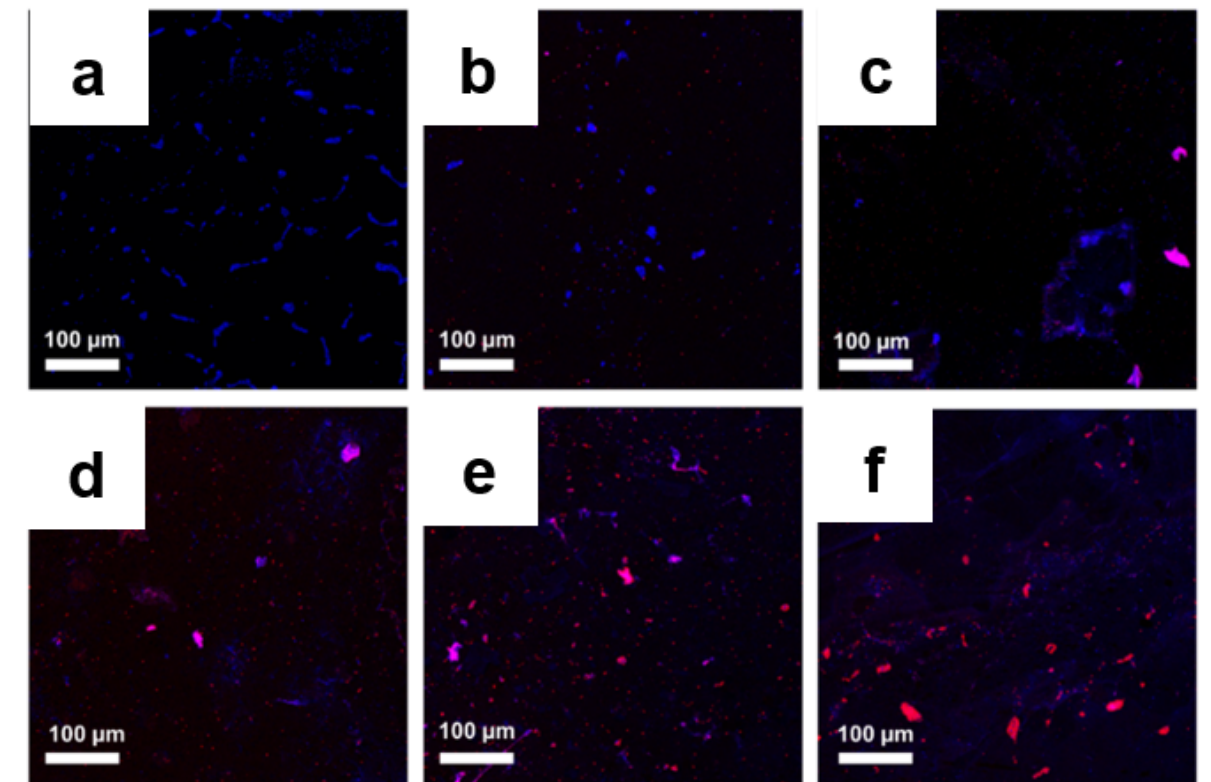
Figure 10. Confocal fluorescent images of control S. aureus ( a ) and S. aureus treated with GO ( b ), Ag NPs ( c ), Ag NPrsms ( d ), GO–Ag NPs ( e ), and GO–Ag NPrsms ( f ) stained with PI (red) and HS (blue).